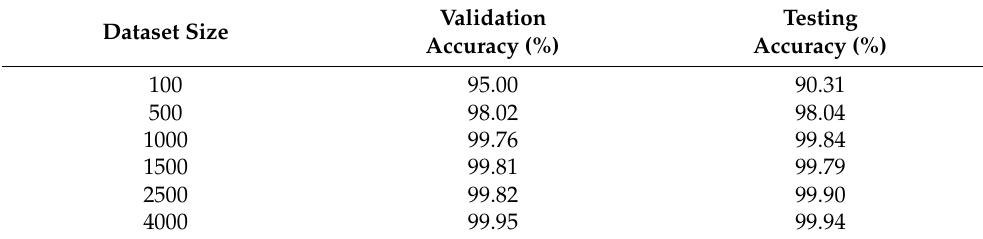
Table 4. Validation and testing accuracy under different dataset sizes based on this